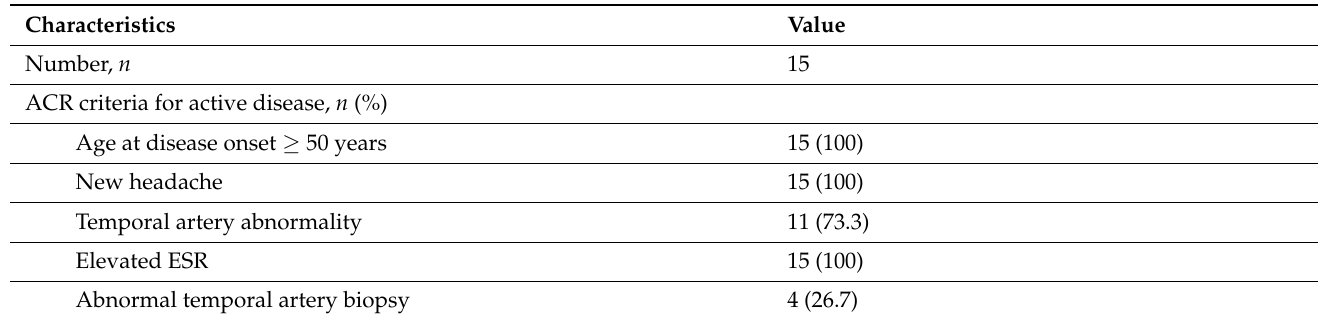
Table 2. Other baseline characteristics of the enrolled GCA